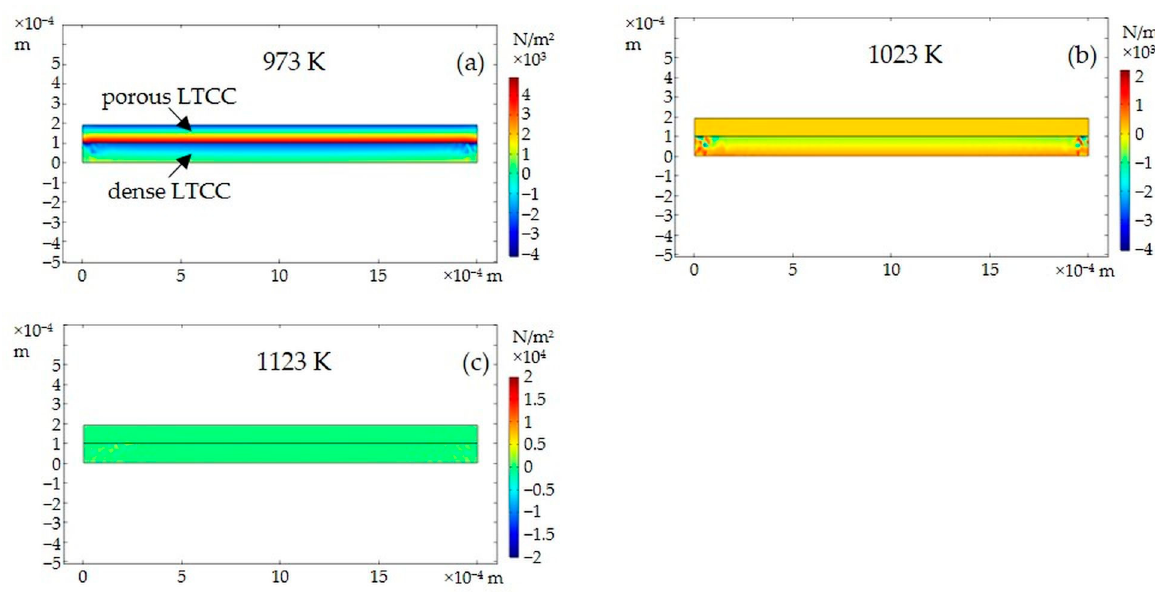
Figure 8. Cross-section distributions of normal stress along the x -axis (i.e., direction along the sample length) at mid-length of the LTCC bilayer for different temperatures: ( a ) 973 K, ( b ) 1023 K, and ( c ) 1123